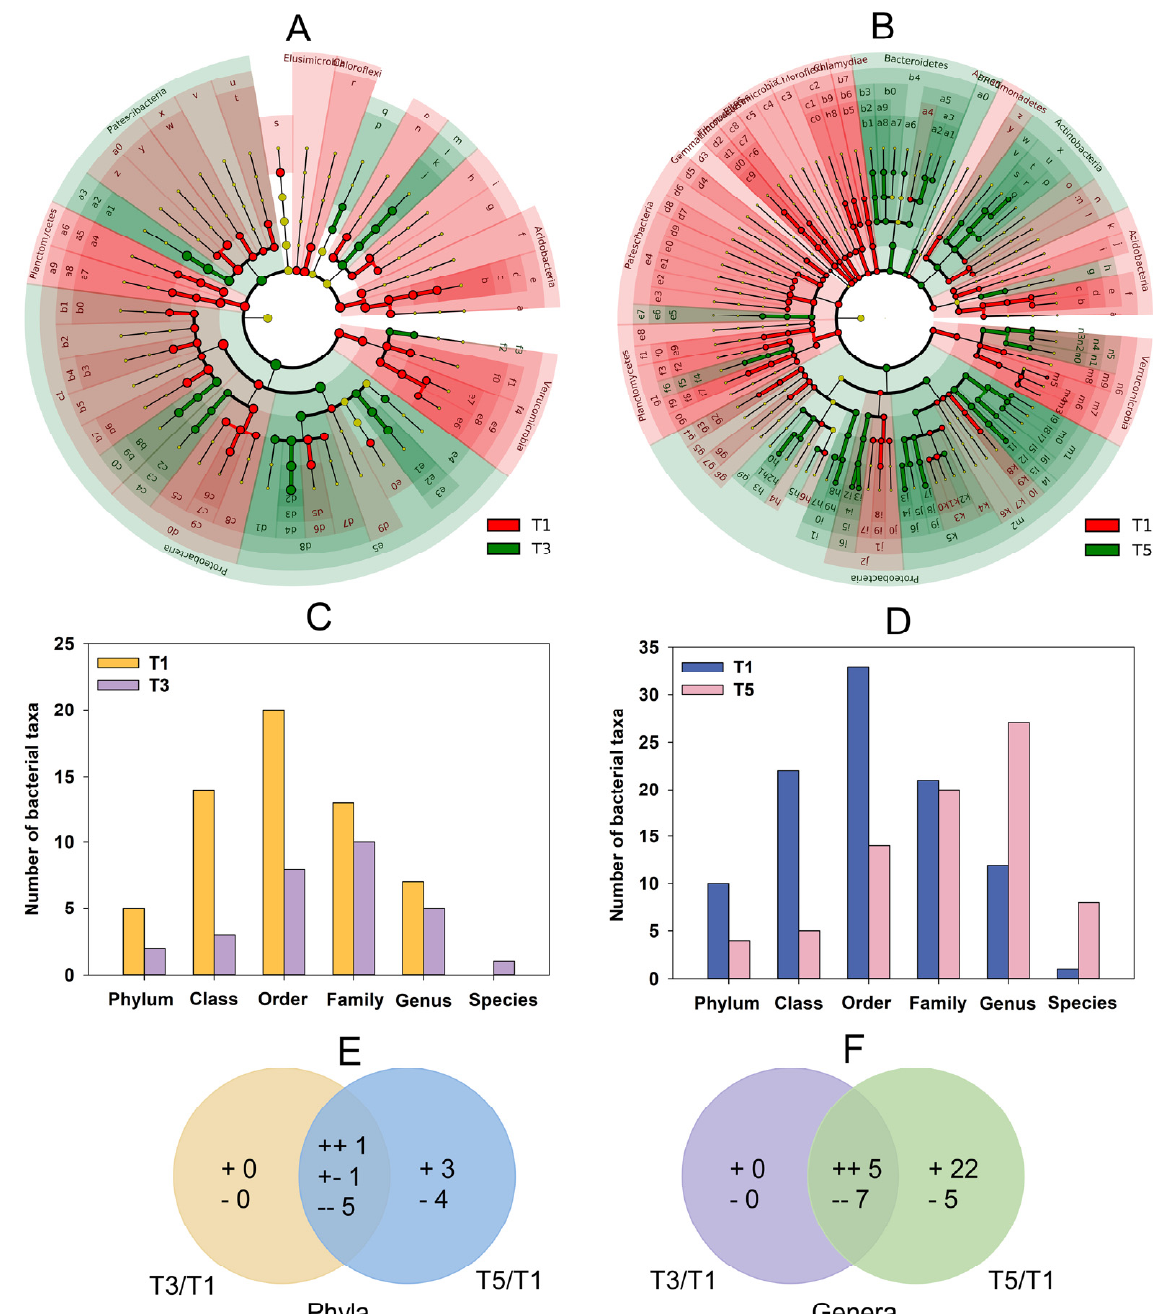
Figure 4. Linear discriminant analysis (LDA) and effect size analysis (LDA scores > 3) showing the indicator bacteria in rhizosphere soils of C. grandiflora supplemented with 0 (T1), 2 (T3) and 8 (T5) g kg − 1 GABA. ( A ) Cladogram showing dominant bacteria between T1 and T3 soils. Identifiers la- belled on the cladogram correspond to those in Supplementary Table S6. ( B ) Cladogram showing